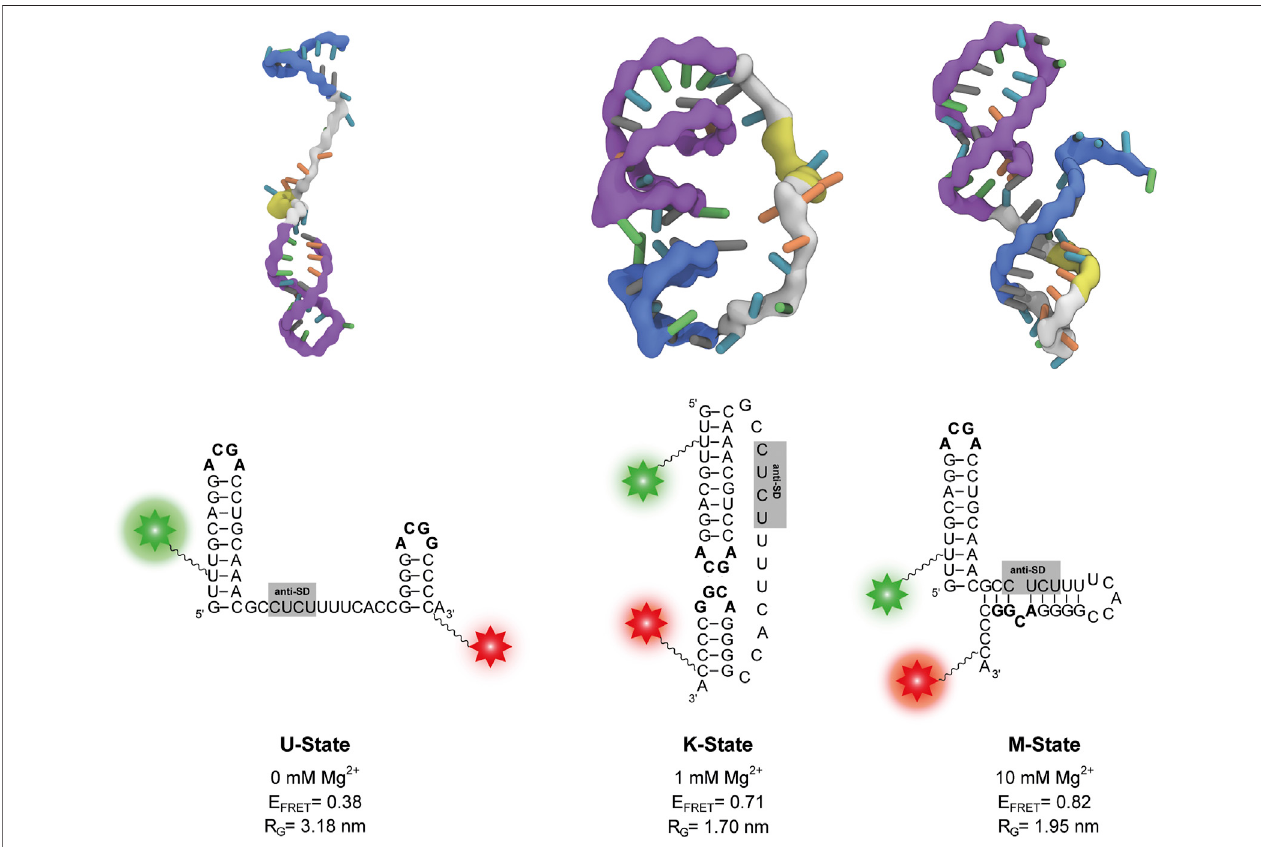
FIGURE 4 | Representative structures of the three states from coarse-grained simulations at different Mg 2+ concentrations. The P1 and P2 stem-loops are coloured inpurple and blue respectively, theanti-SD sequence iscoloured in yellow and therest ofthelinker iscoloured ingrey.The correspondingsecondary structure is shown below each three-dimensional structure. Positions of Cy3 and Cy5 fl uorophores of the smFRET construct are depicted as a green and red star, respectively. The calculated FRET ef fi ciency (E FRET ) of each structure averaged over different dye orientations is given. R G describes the radius of gyration.